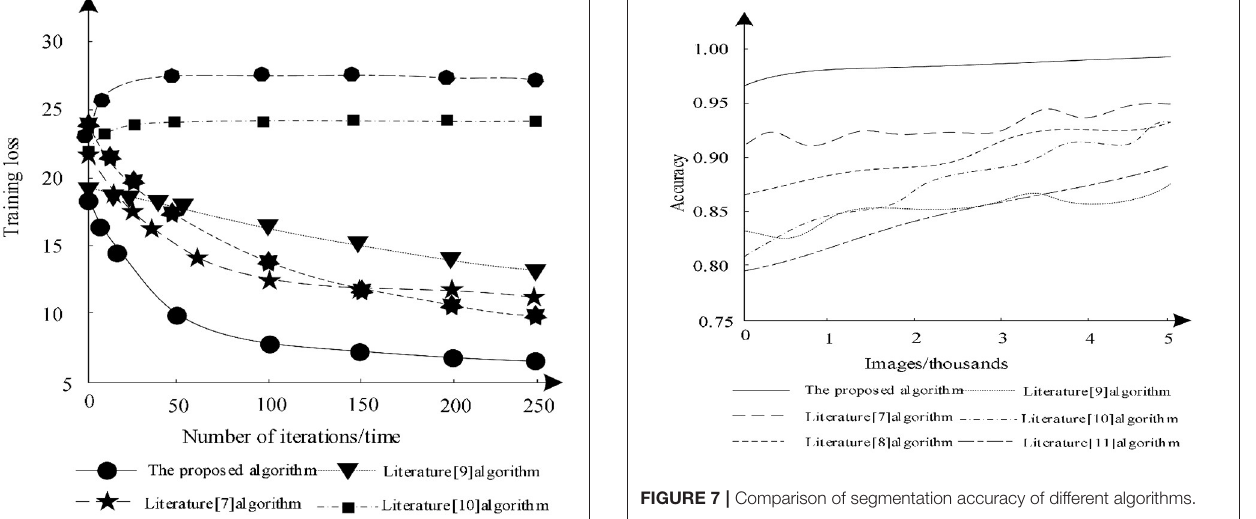
FIGURE 7 | Comparison of segmentation accuracy of different